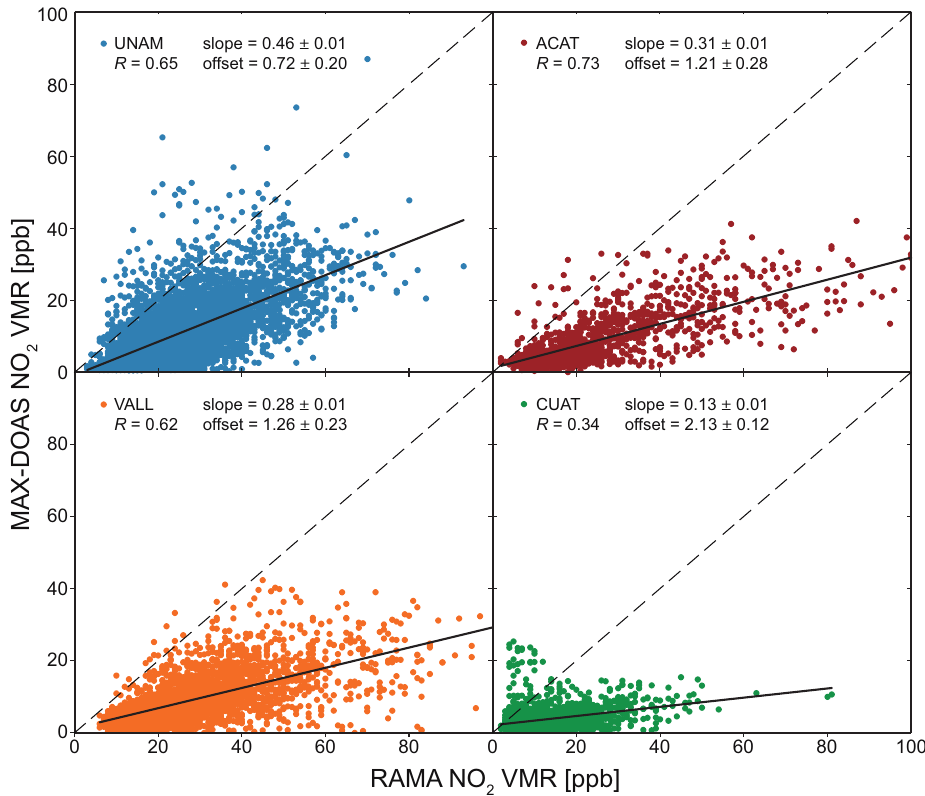
Figure 8. Dispersion plot with coincident hourly means between surface measurements and the average VMR from MAX-